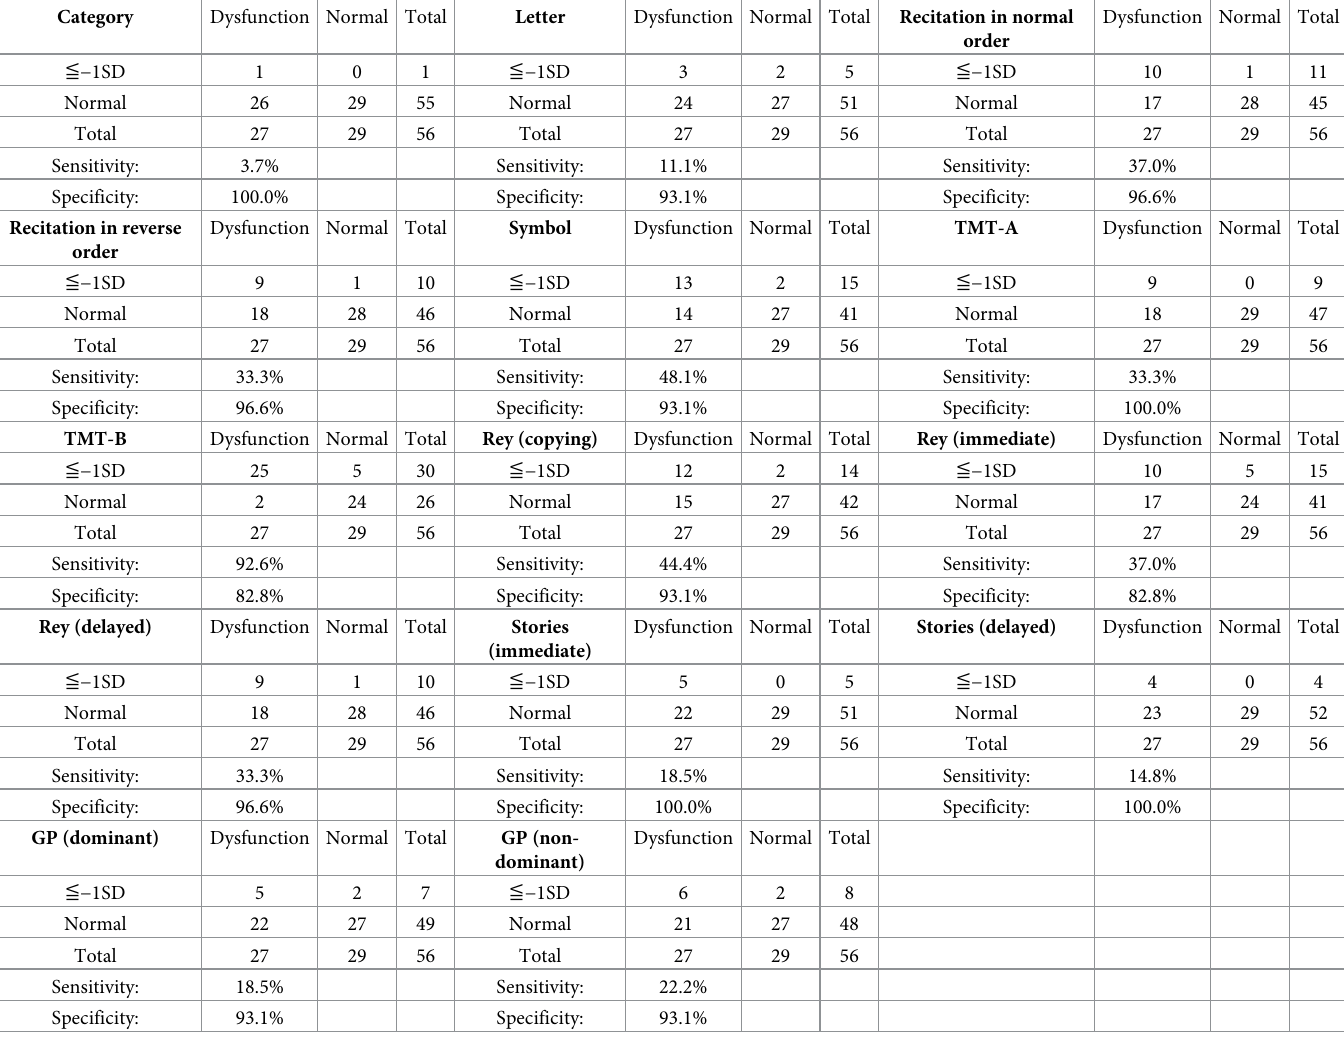
Table 2. The sensitivity and specificity for the NDHH group in each